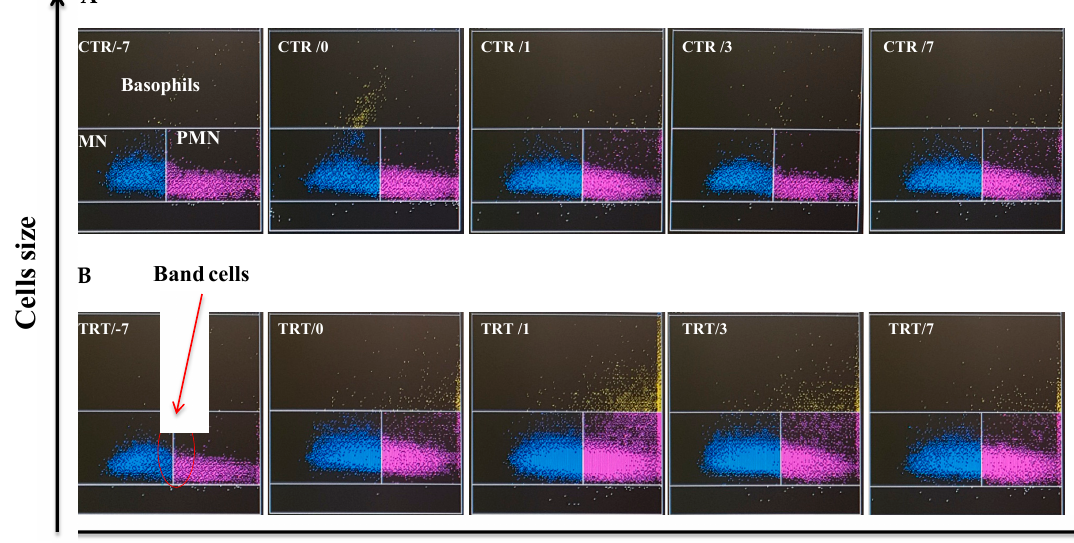
Figure 3. Effect of Pegbovigrastim on band cells evaluating baso cytogram provided by ADVIA 2120 Hematology Analyzer. Representative cytograms during the transition period of Simmental cows treated either with saline solution (CTR; A ) or 2 subcutaneous injections of pegbovigrastim (PEG; B ) or at − 7 days relative to calving and within 6 h after calving. In blue are indicate mononuclear (MN) while in red polymorphonuclear (PMN) populations: band cells (red circle) appear between the MN and PMN populations.